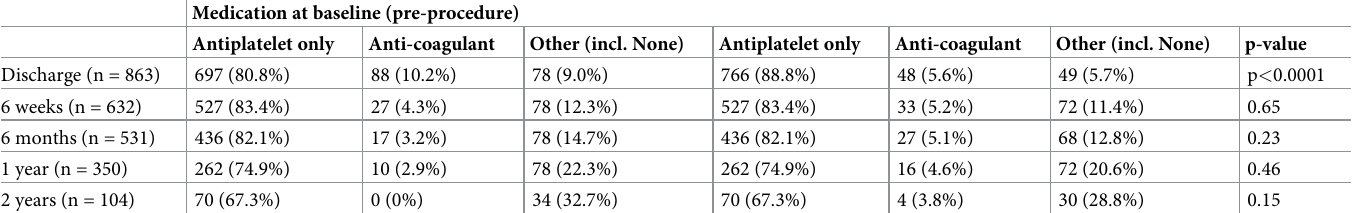
Table 4. Medication use over time in patients with device implanted and completed follow-up compared with baseline (using available paired data). p-values from 3x2 Fisher’s exact tests. Medication at baseline (pre-procedure) Antiplatelet